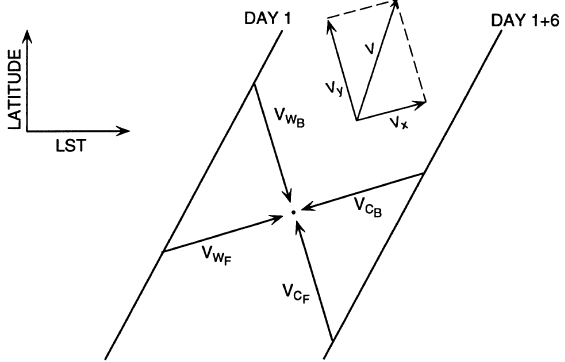
Fig. 3. Schematic illustration of the viewing geometry employed in the warm-side/cold-side zero